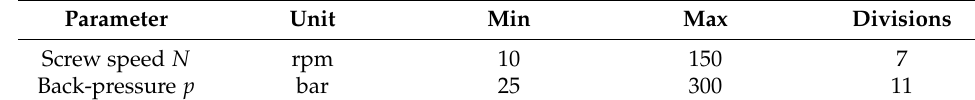
Table 4. Variation of screw speed N and back-pressure p for screw characterization.